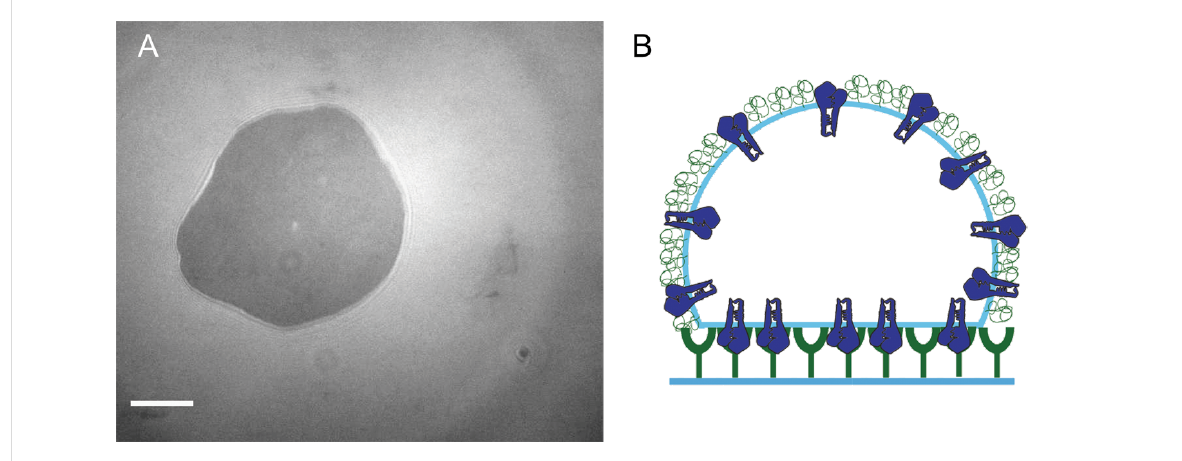
Figure 3: GUVs containing integrins interacting with a fibrinogen-coated substrate: (A) adhesion is detected with RICM (black patch), (B) Scheme of the minimal cell system. The scale bar represents 10 μ m (Reprinted with permission from [54]. Copyright (2009) Elsevier Ltd.)